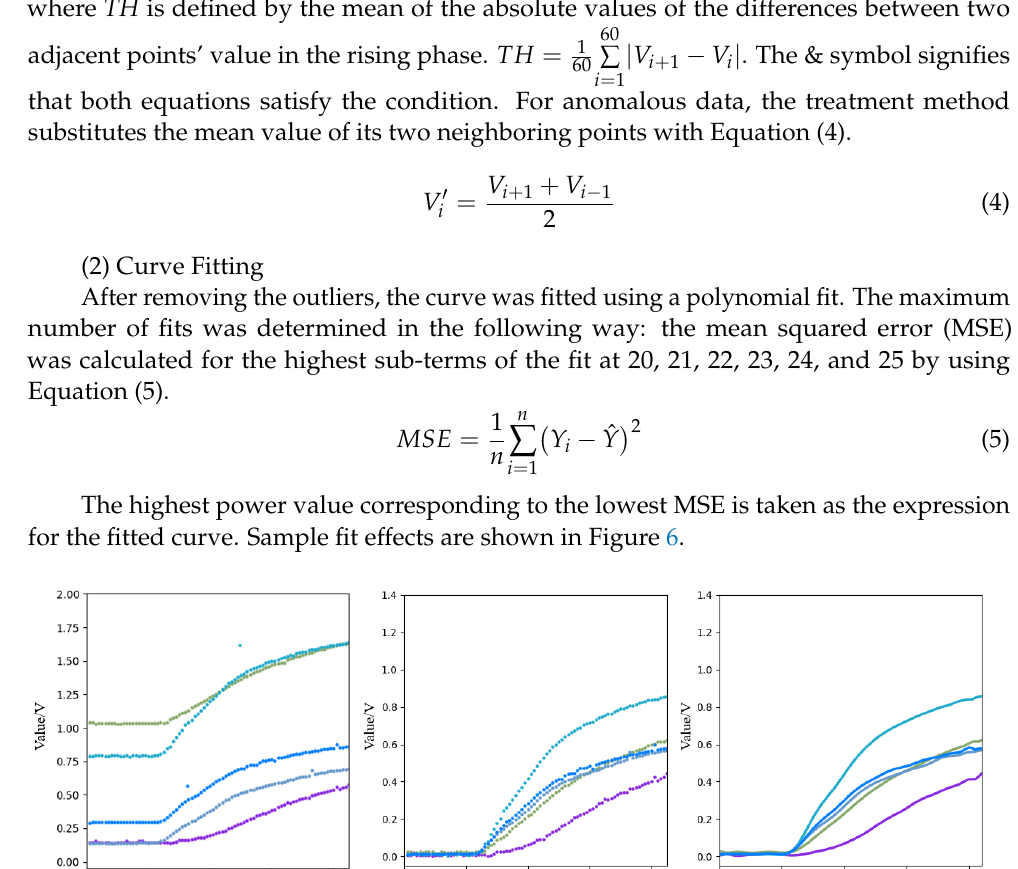
Figure 7. Selected maximum response value, peak area, maximum first-order derivative, maximum second-order derivative.